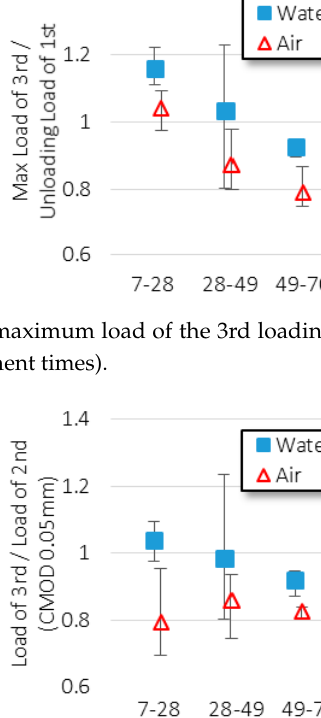
Figure 12. Ratios between load of 3rd loading and load of 2nd loading with CMOD = 0.05 mm (different crack inducement time).